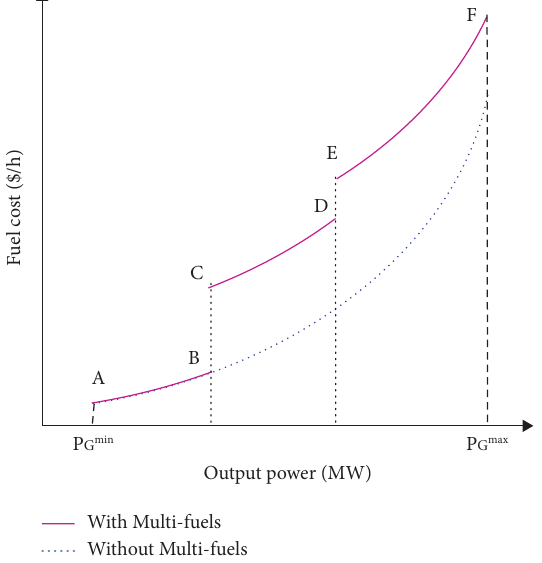
Figure 1: Cost curves of a generator with and without